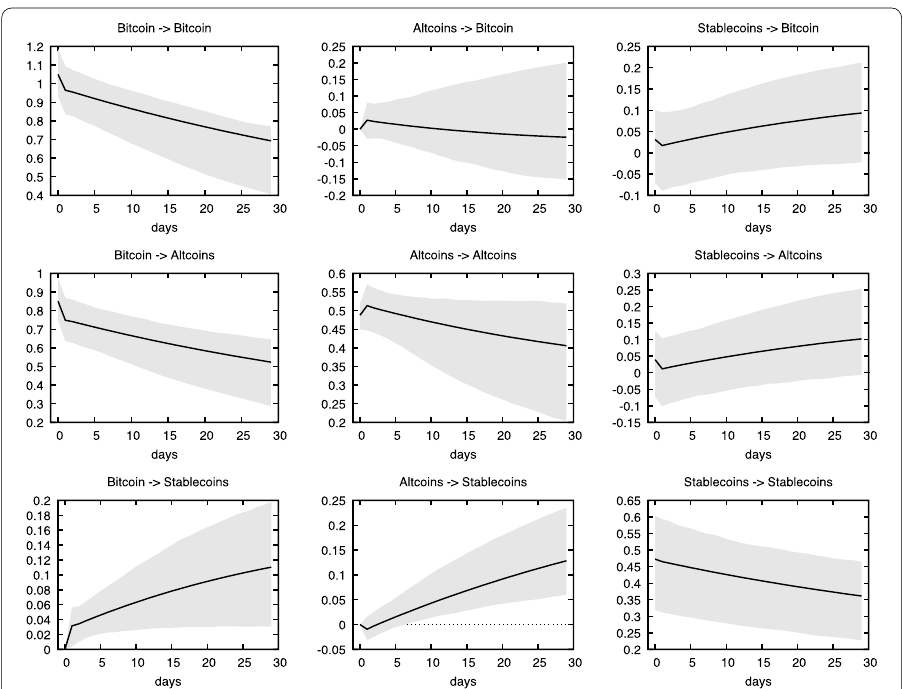
Fig. 7 Impulse-response functions of market capitalizations for 2018–2020. Impulse response functions based on the Toda and Yamamoto (1995) specification VAR with 2 lags without a time trend are shown for the time horizon of 30 days ( x -axes), with a standard deviation of the given series as a unit of measurement. The rest of the notation holds from Fig. 2